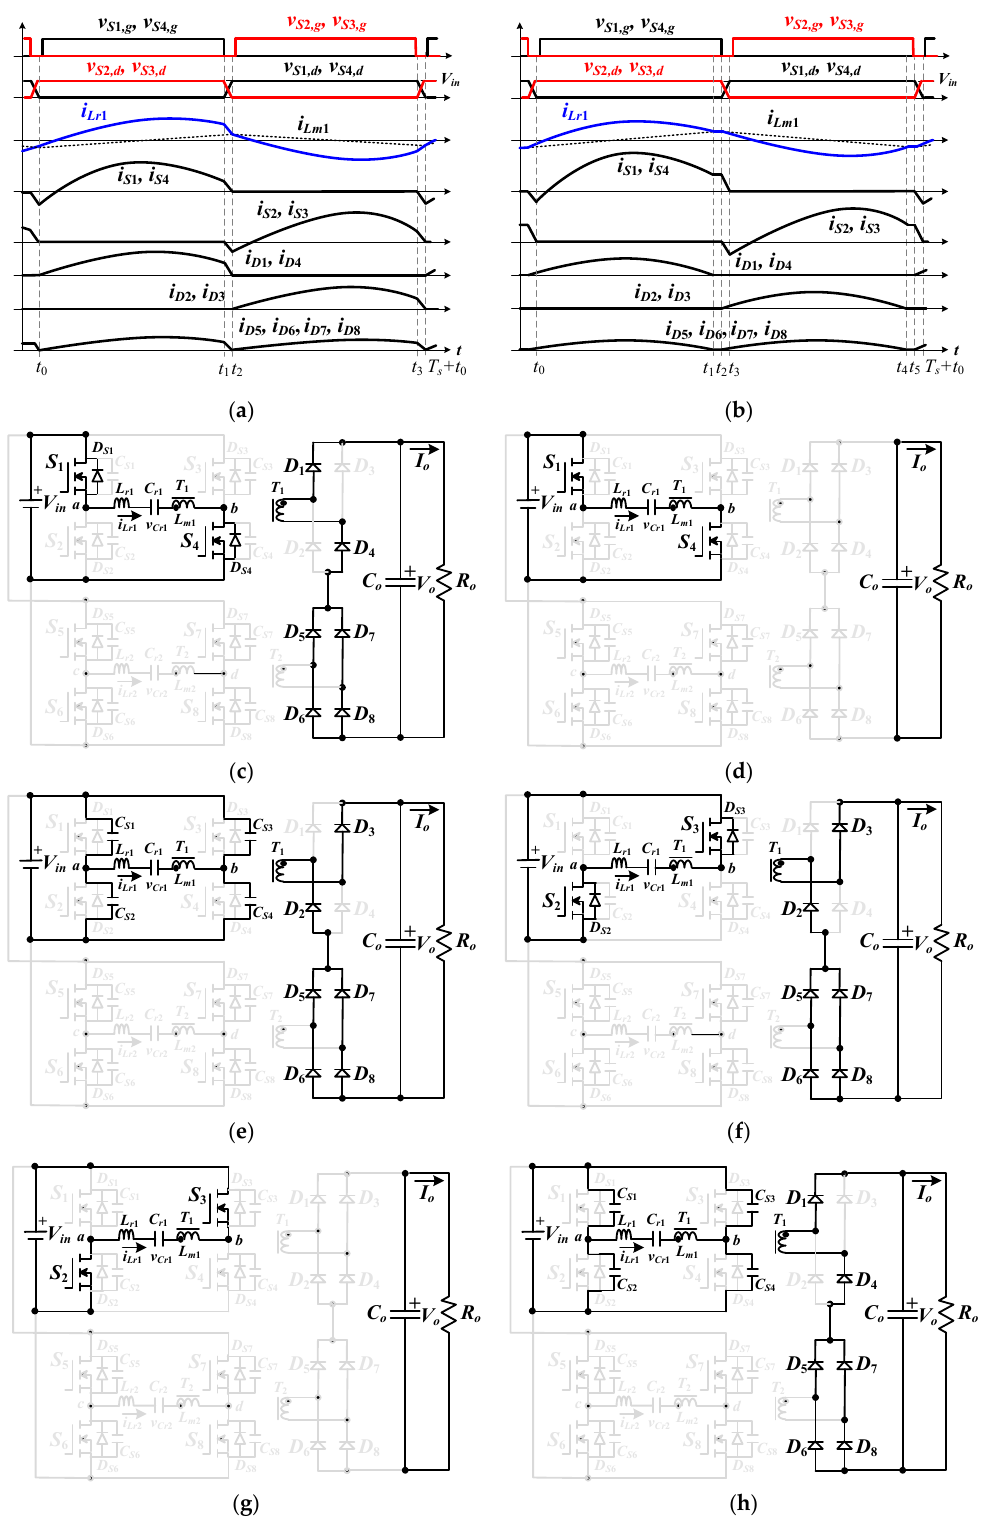
Figure 3. Circuit waveforms and equivalent mode circuits at low-voltage output. ( a ) PWM waveforms when f s > f r ; ( b ) PWM waveforms when f s < f r ; ( c ) mode 1; ( d ) mode 2; ( e ) mode 3; ( f ) mode 4; ( g ) mode 5; and ( h ) mode